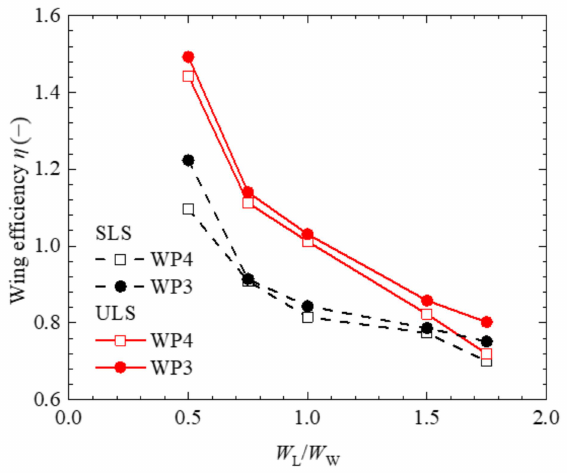
Figure 22. Variation in wing efficiency for winged monopiles with various wing